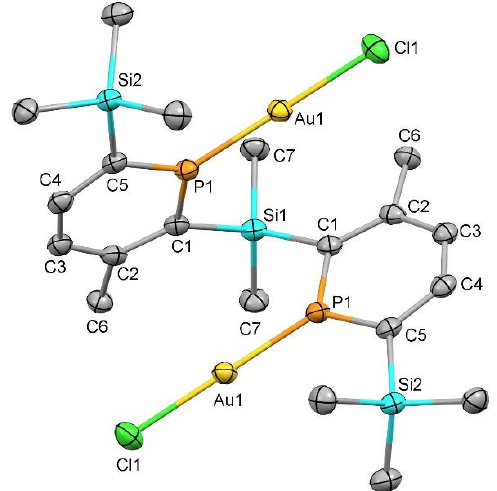
Figure 2. Molecular structure of 21 (thermal ellipsoids at 50%; all H atoms have been omitted for clarity). Selected bond lengths (Å ) and angles (°): Au1-Cl1 2.2742(12), Au1-P1 2.2078(12), P1-C1 clarity). Selected bond lengths (Å) and angles ( ◦ ): Au1-Cl1 2.2742(12), Au1-P1 2.2078(12),